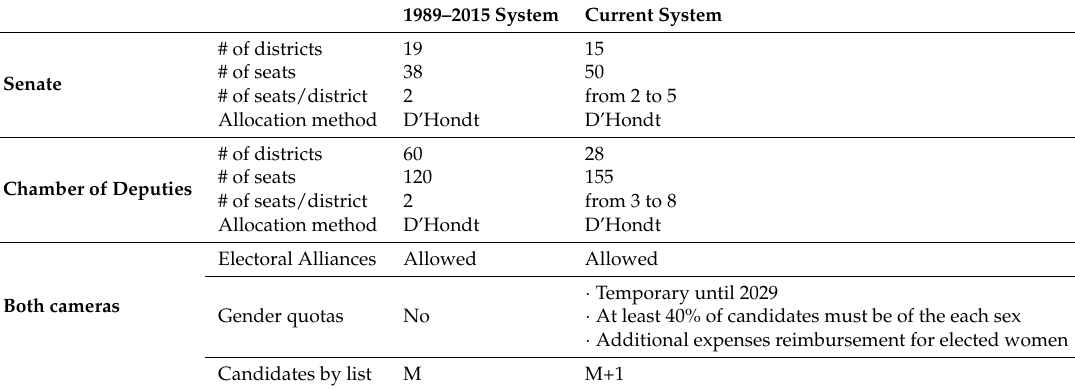
Table 1. Comparison of the main characteristics of the electoral system valid from 1990 until 2015 and the reformed electoral system established in 2015 (see [39]). M stands for the number of representatives under election for the